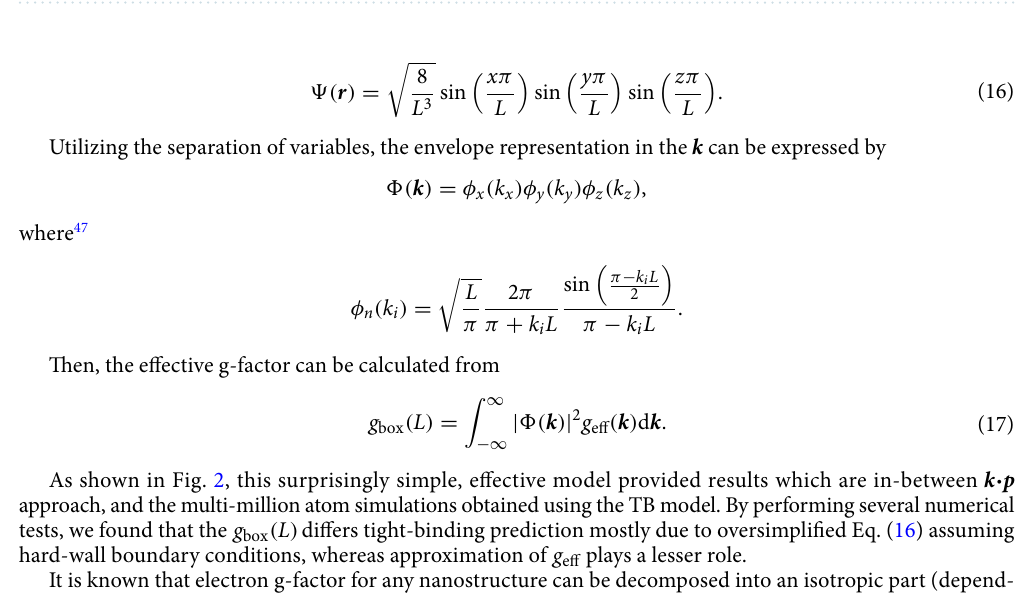
Figure 3. (Color online) The schematic view of two cubic boxes: ( a ) the same ion-terminated corresponding to S 4 symmetry and ( b ) mixed-anion-cation-terminated leading to a lower C 1 symmetry. Red color corresponds to anions (arsenic) and blue color marks cation